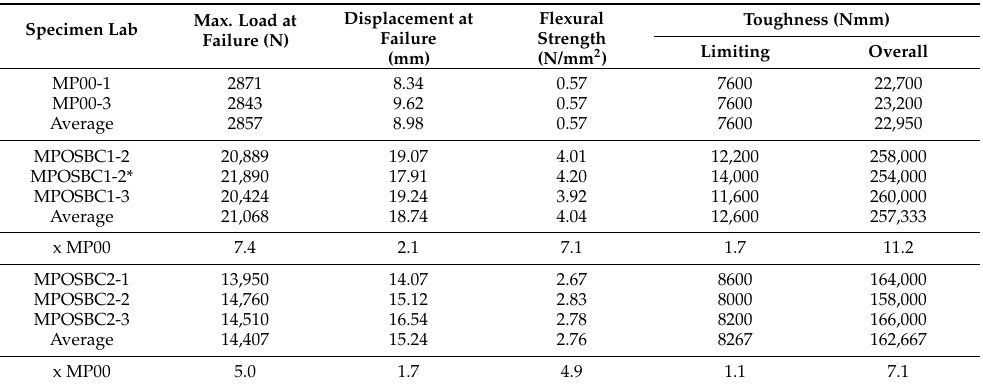
Figure 8. MP specimen with OSB: ( a ) geometry and ( b ) failure pattern (MPOSBC1-3 as an example). Table 3. Summary of flexural strength test